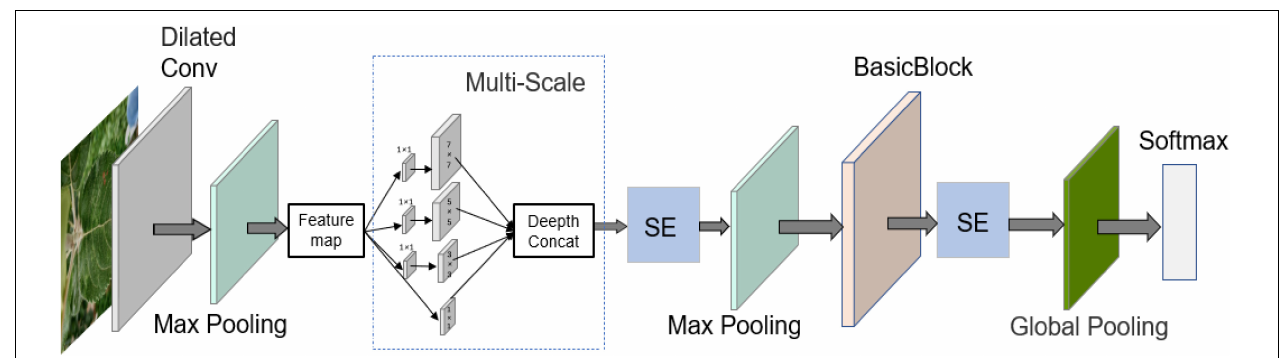
FIGURE 4 | BasicBlock + SE module.